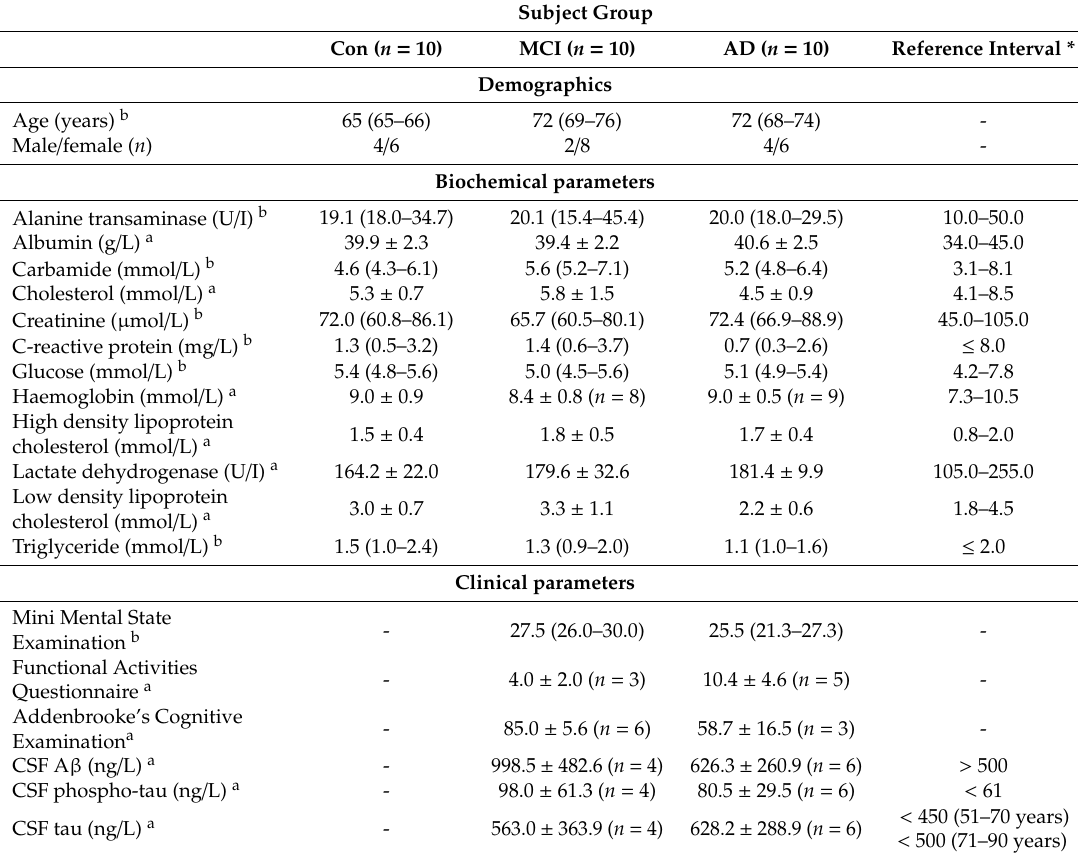
Table 1. Characteristics of study